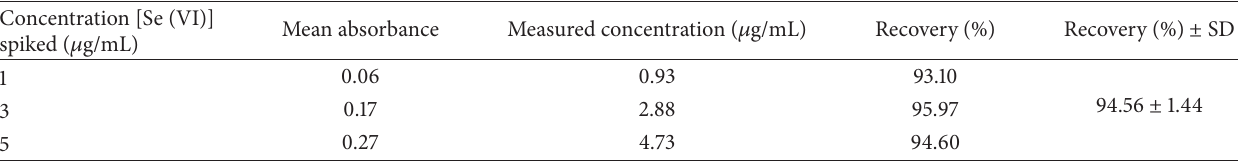
Table 1: Method validation: the concentration of extracts possessing known amounts of selenium determined by gravimetric analyses and by UV